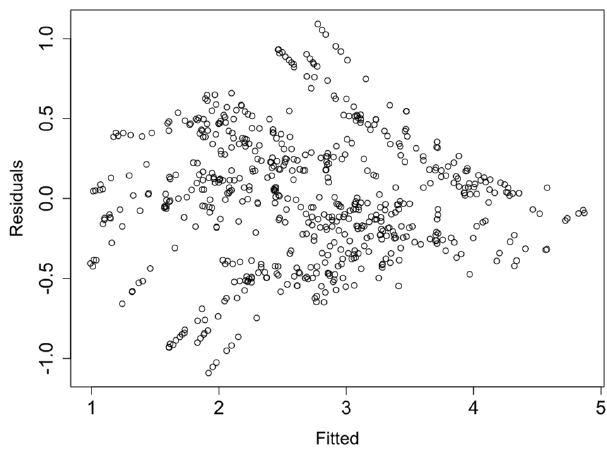
Figure 15. Fitted vs. residual values—Group 3.